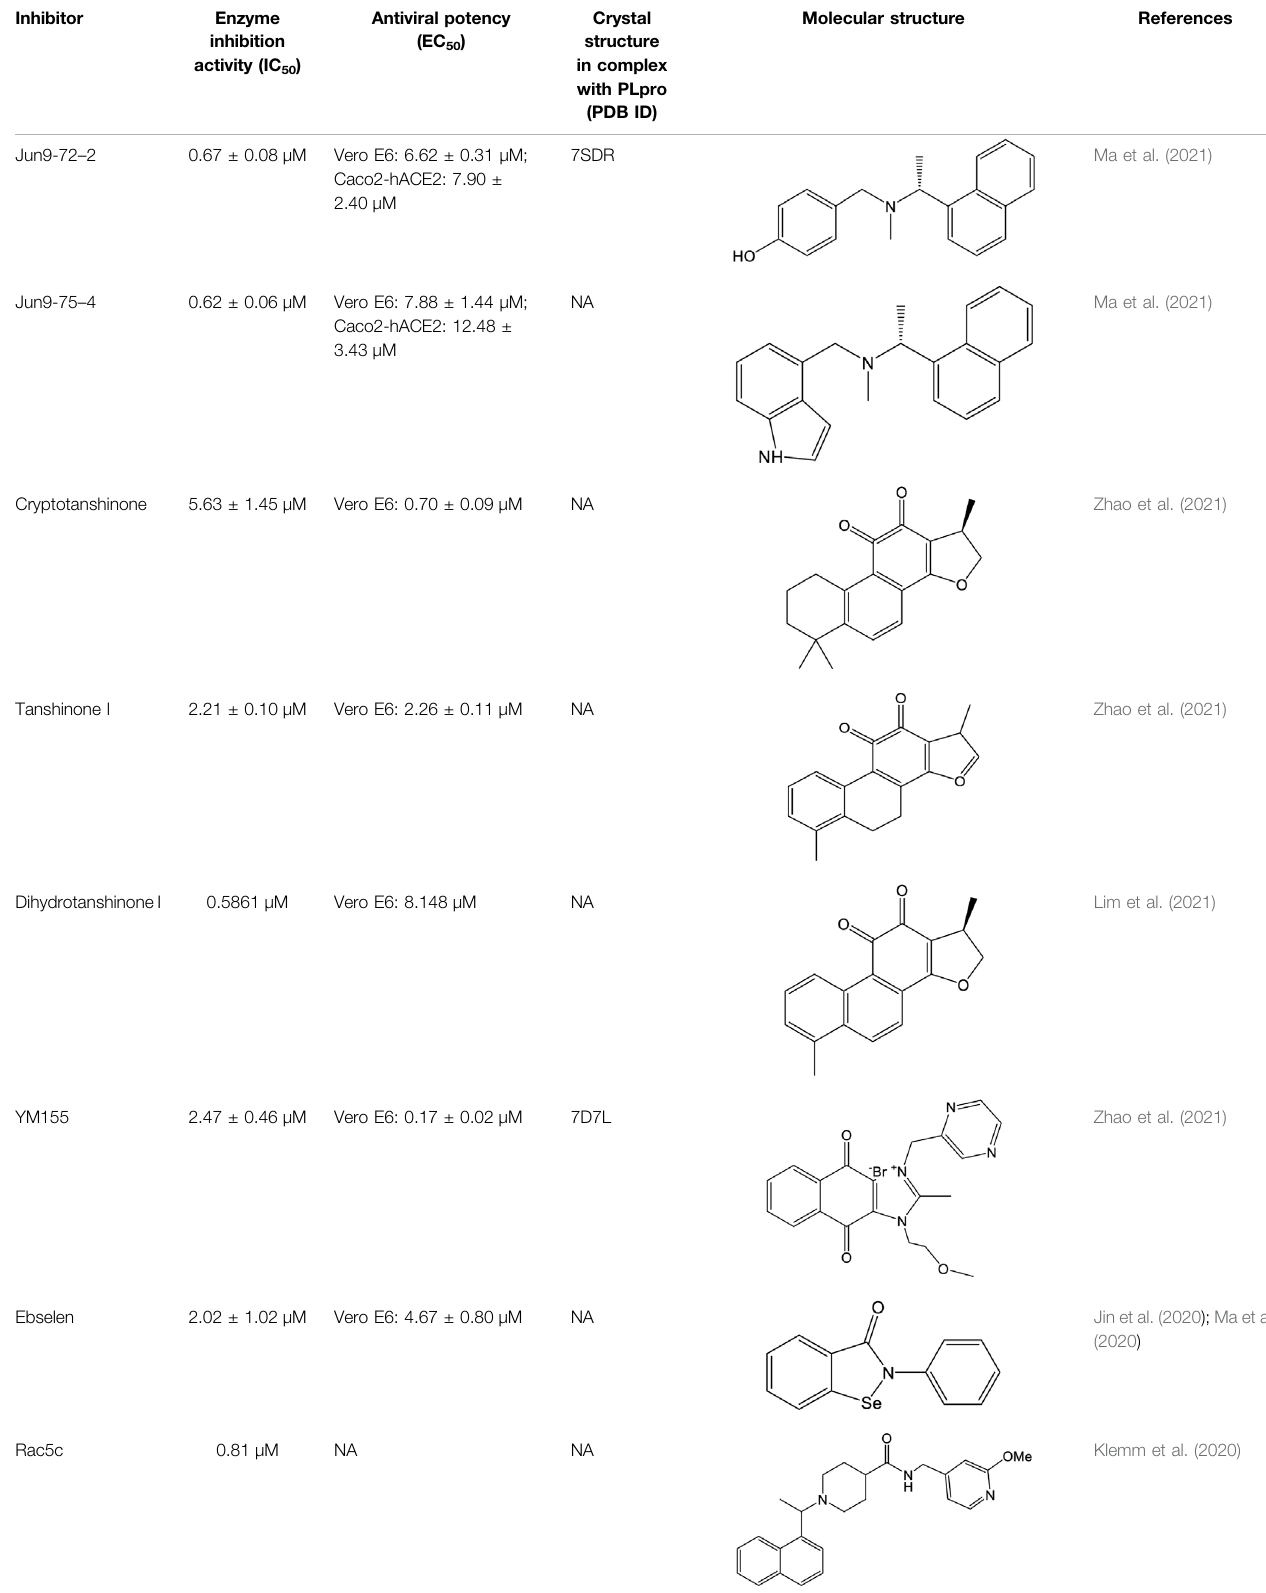
TABLE 1 | ( Continued ) Representative potential inhibitors of SARS-CoV-2